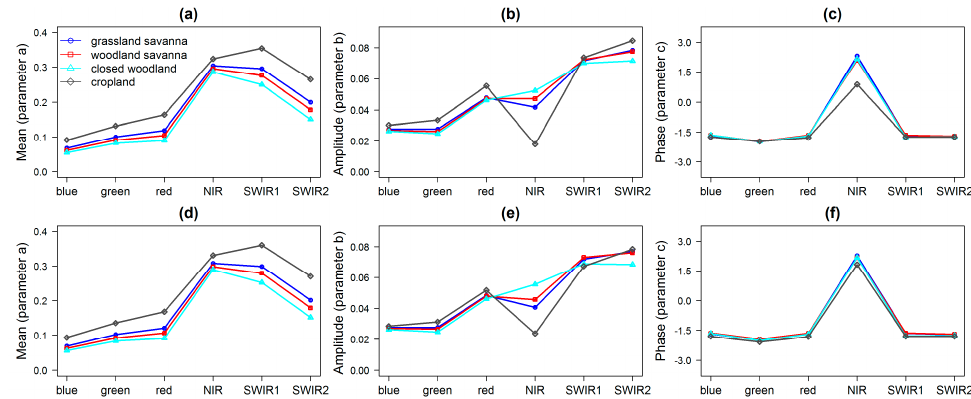
Figure 4. Mean values of seasonal features ( a – c ) before and ( d – f ) after burnt pixel removal: ( a , d ) mean (parameter a ); ( b , e ) amplitude (parameter b ) and ( c , f ) phase (parameter c ). Mean value of tree crown cover was 0.17 for grassland savanna, 0.38 for woodland savanna, 0.57 for closed woodland, 0.08 for cropland.